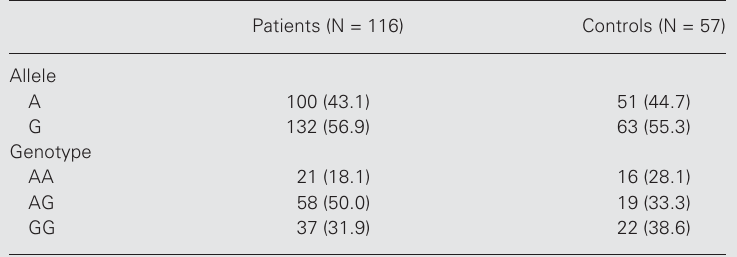
Table 3. Allele and genotype frequencies of -1185A/G von Willebrand factor gene polymorphism in patients and control